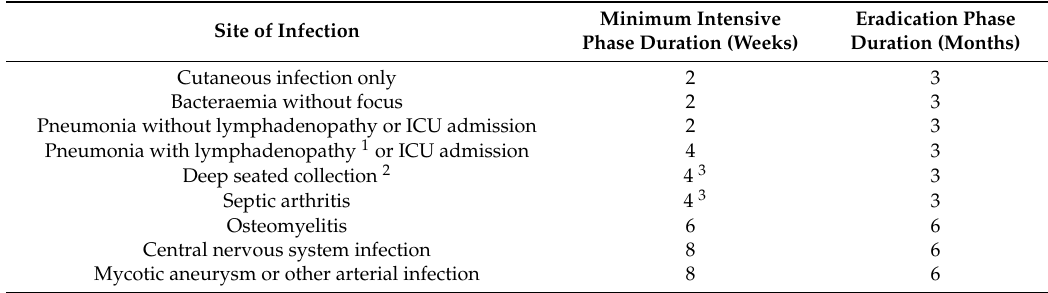
Table 2. Recommended antibiotic duration for the treatment of melioidosis in